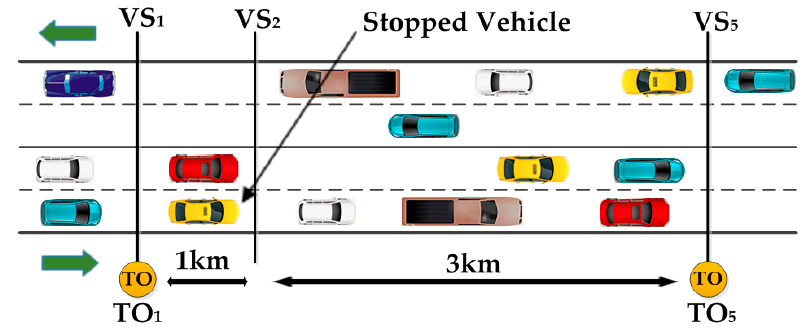
Figure 6. Location of TOs and virtual strips from the entry of a four lane highway [14].